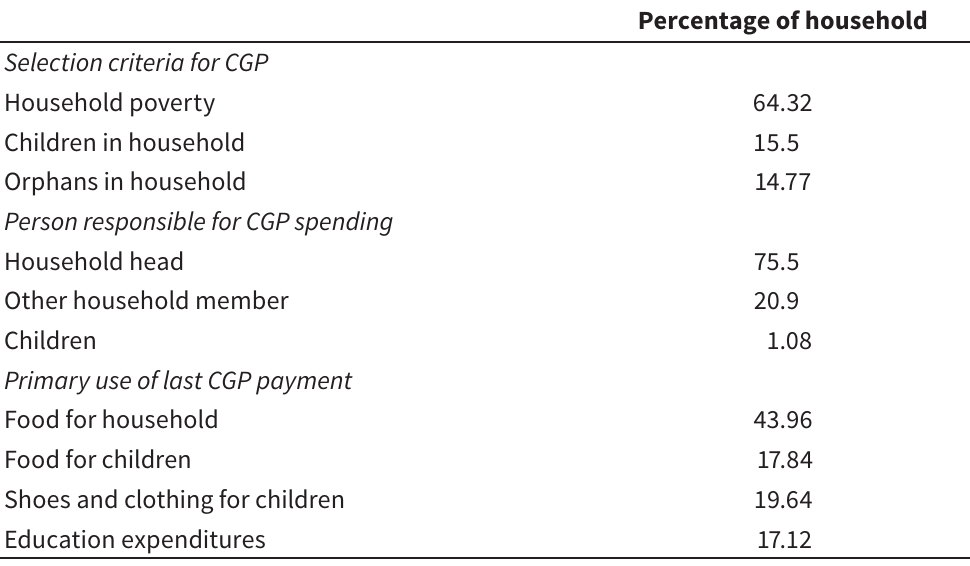
Percentage of household